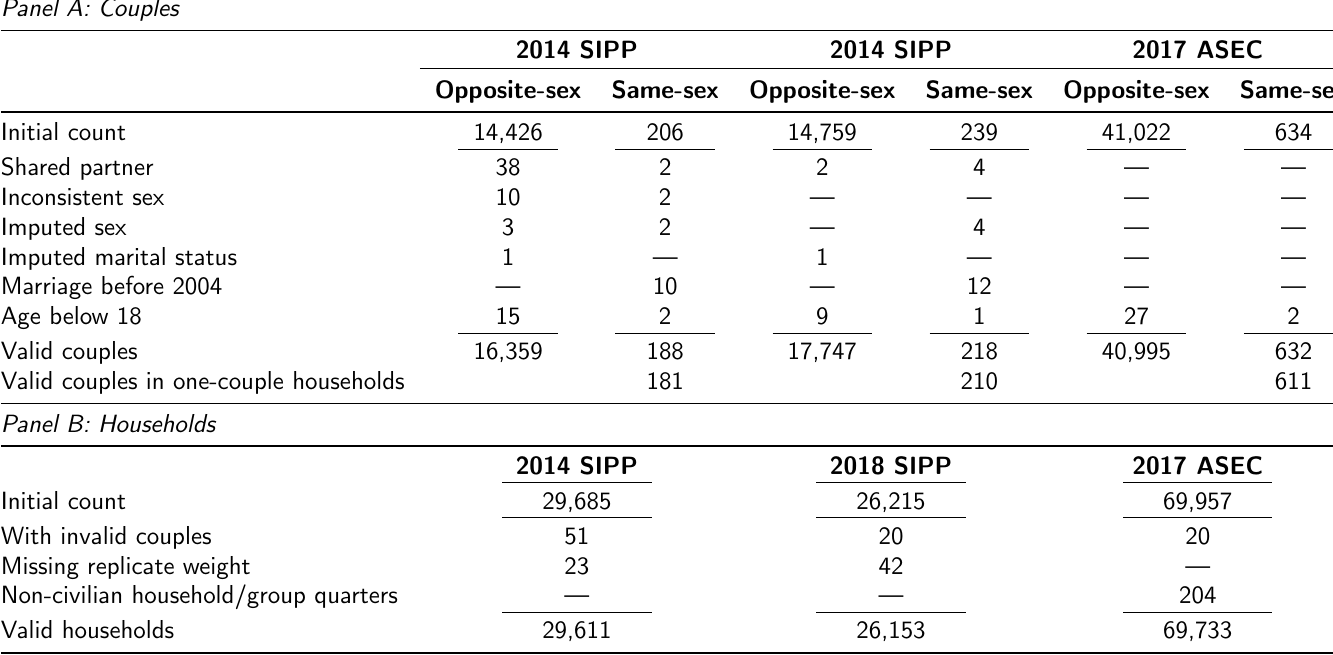
Table B.2: Sample counts of couples and households after